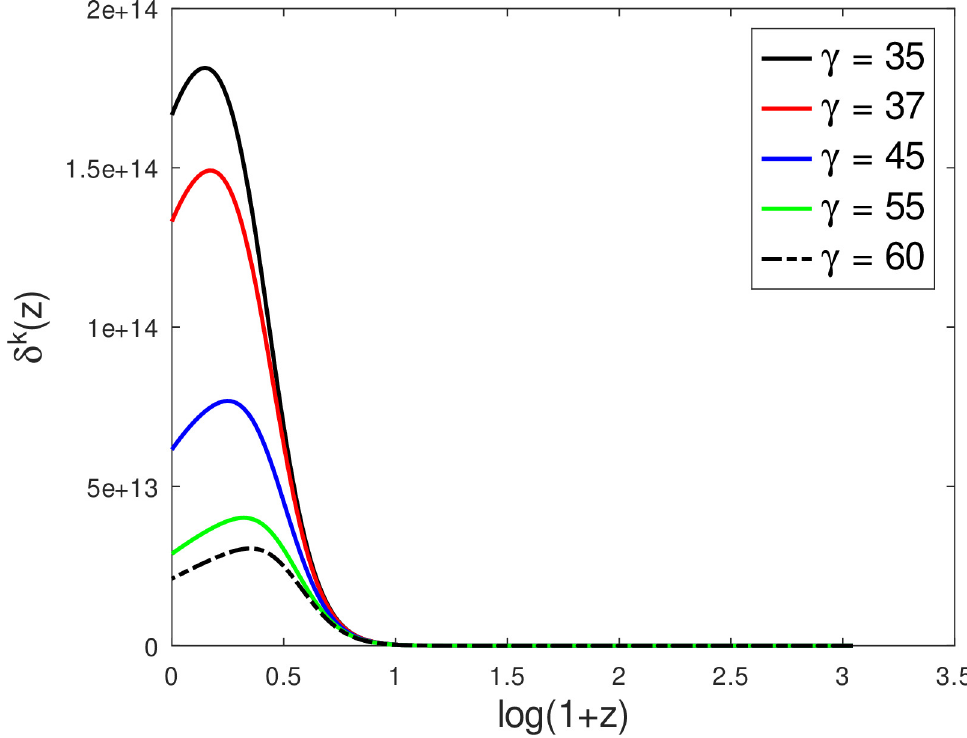
Figure 7. The variation of the matter density perturbations δ k ( z ) for a viscous Bianchi type-V cosmological model vs. redshift for short wavelength. The same initial conditions as the previous figures are used, but this time with viscosity